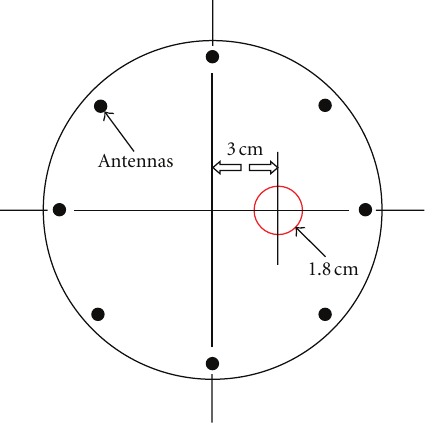
Figure 4: Position of the test tube with respect to the microwave antennas within the imaging tank (top view). (There are 16 antennas in total, only 8 are shown for simplicity. The antennas are positioned equiangularly on a 15.2 cm diameter circle.)